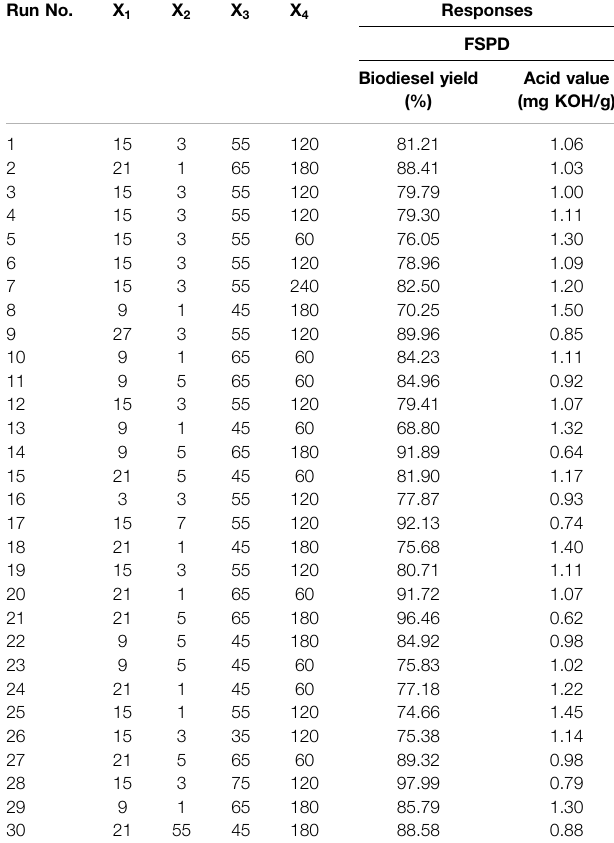
TABLE 2| Experimental designmatrixforthesimultaneoustransesteri fi cation and esteri fi cation of NSO. Run